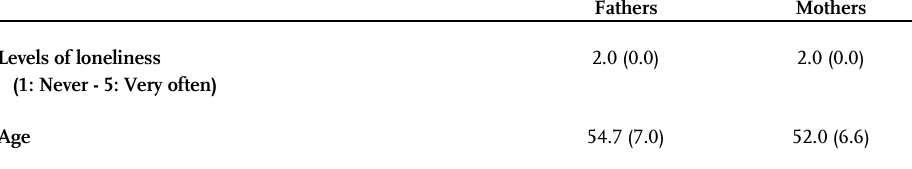
Table 2 : Descriptive sample statistics for parents: Means (standard deviations) Levels of